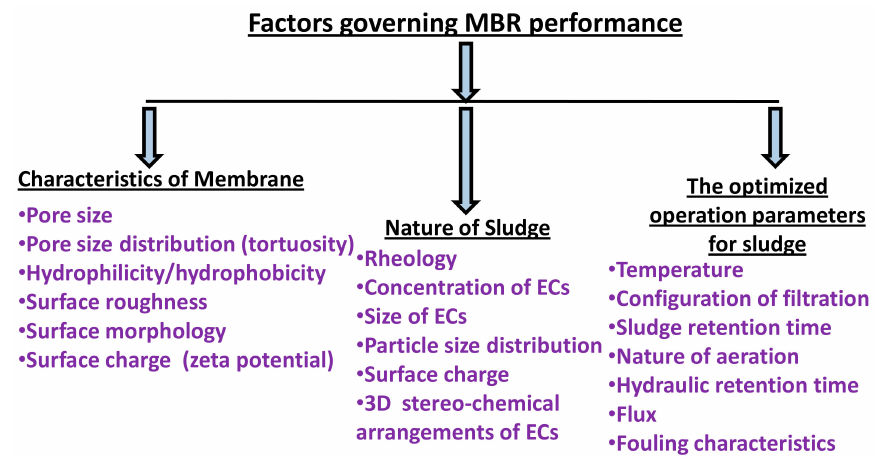
Figure 8. The factors influencing the performance of membrane bioreactor